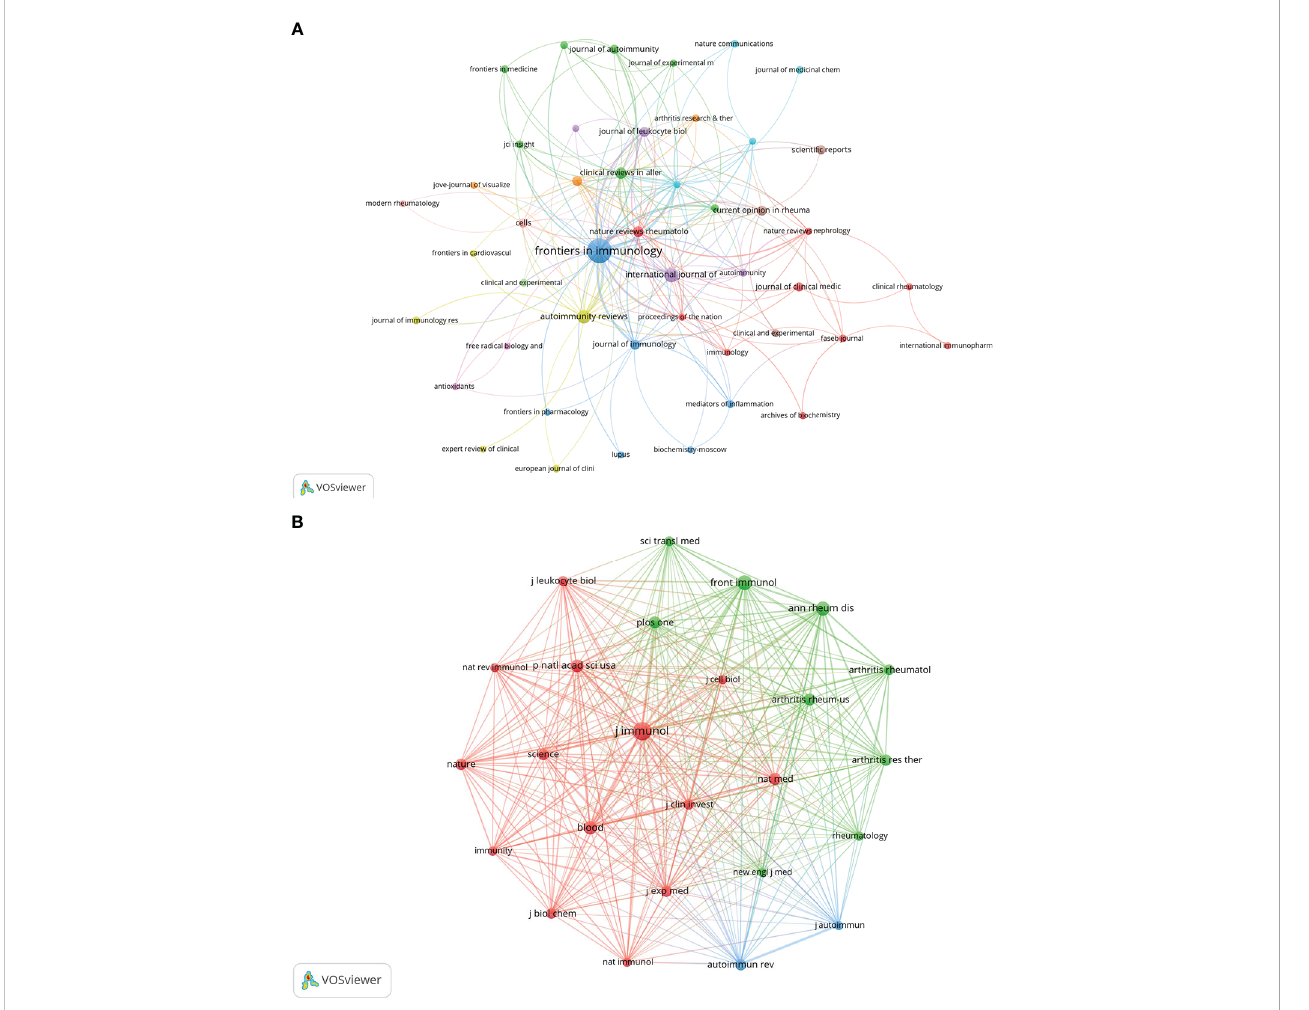
FIGURE 5 Visualization of journals (A) and co-cited journals (B) on the research of NETs in AIDs.